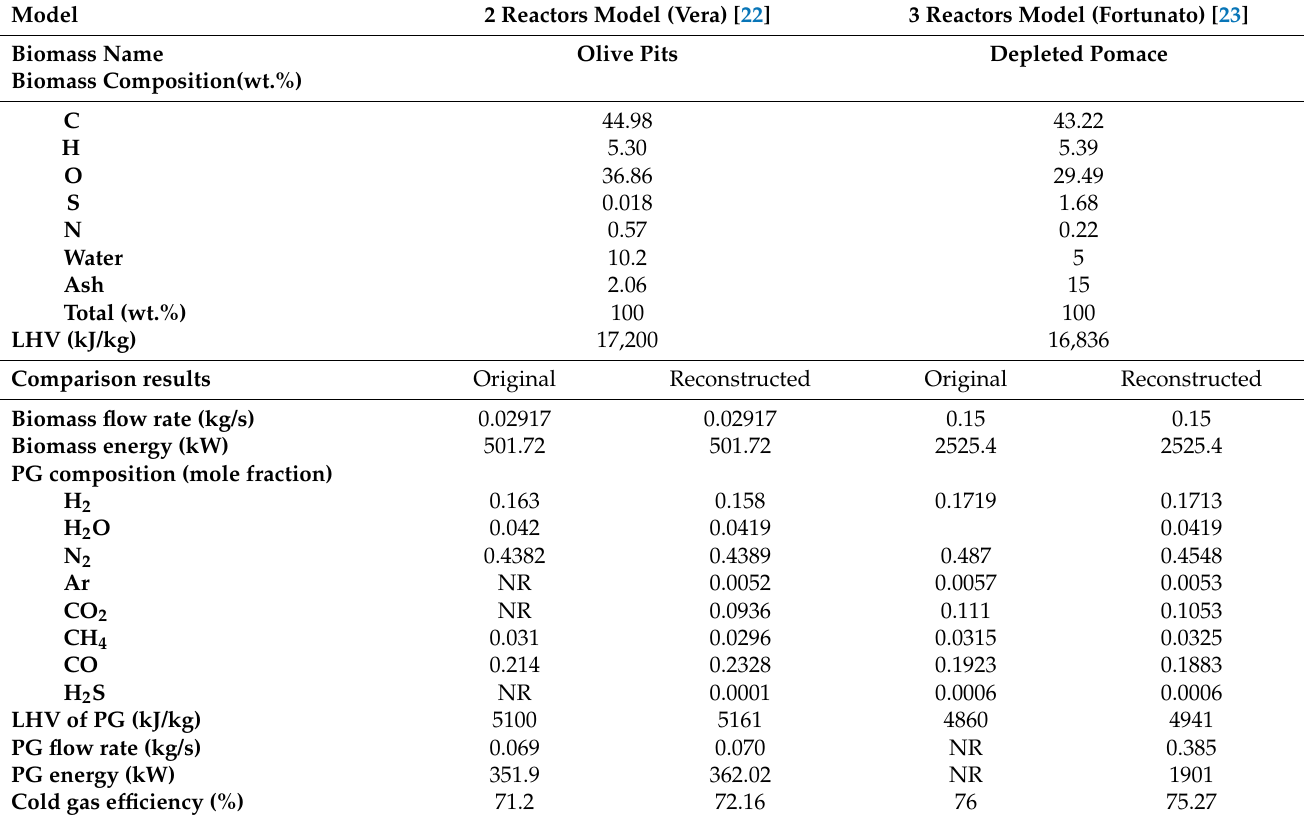
Table 2. Comparison results of the reconstruction model and the original